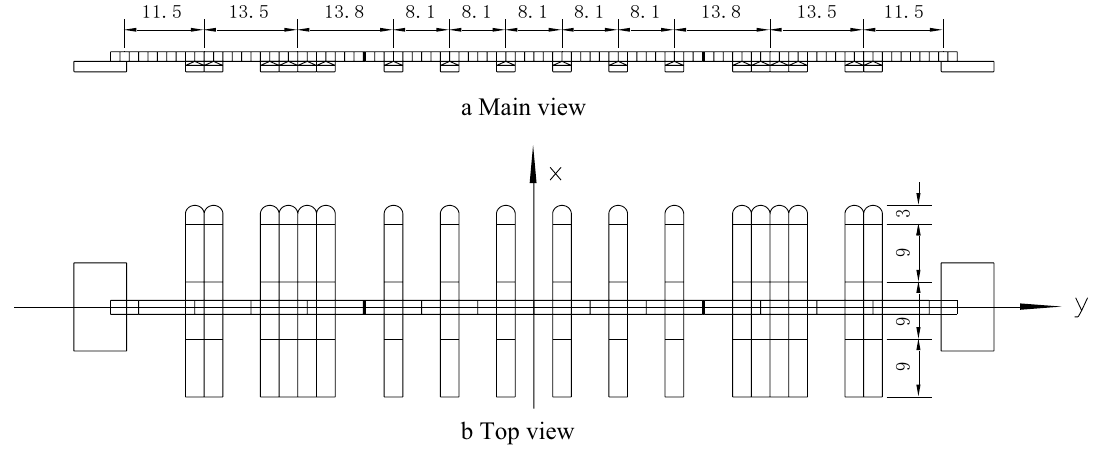
Fig. 1 Layout schematic of the 67-type railway bridge (Unit: